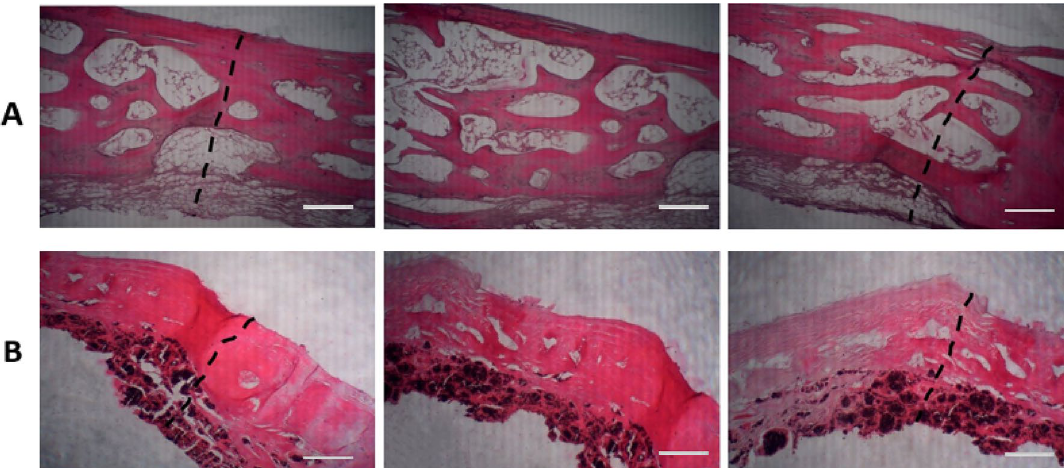
Figure 7. Histological findings after 12 weeks; H&E stain of the bone defects repaired by Col ( A ) and Col-rGO ( B ) scaffolds. Images for each group were illustrated from three different parts of the same location. The dotted line indicates the border between intact bone and scaffolds. Scale bar 100